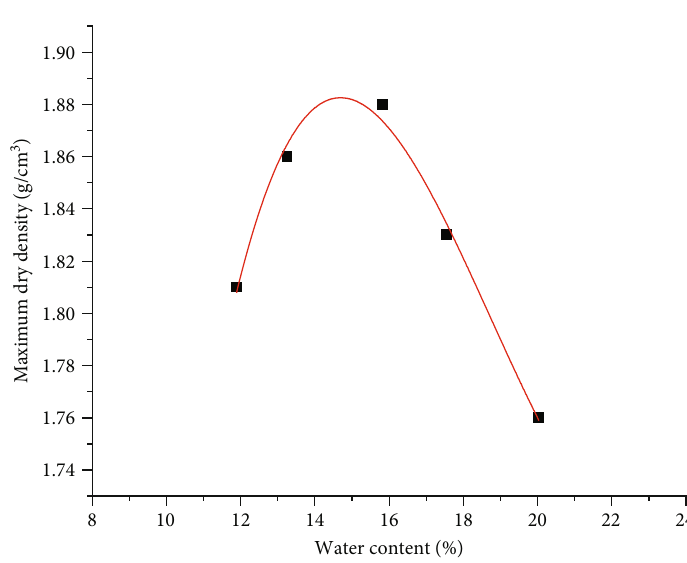
Figure 5: The curve of moisture content versus dry